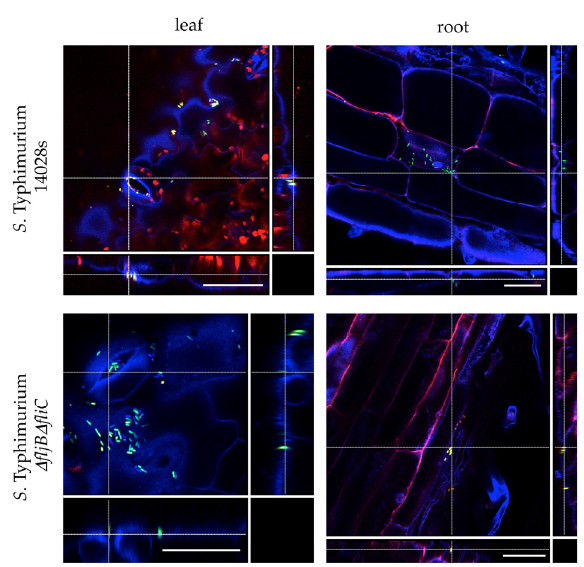
Figure 2. Attachment to plants does not require flagella. Salmonella enterica serovar Typhimurium strain 14028s ( S. Typhimurium 14028s) and the double mutant S . Typhimurium ∆ fljB ∆ fliC were labeled with the green fluorescent protein (GFP) using the pSM1890 GFP-plasmid. Plants were dip-inoculated with a 10 8 CFU / mL suspension of GFP-expressing Salmonella . Attachment of Salmonella to plant roots and leaves was assessed after 24 h, using the confocal laser scanning microscopy with the following set up: excitation 405 nm, emission 430–480 nm (blue); excitation 488 nm, emission 500–550 nm (green) and excitation 561nm, emission 600–680 nm (red). Auto-fluorescence of chloroplasts is indicated in red and GFP-labeled Salmonella cells are indicated in green. Scale bars indicate 20 µ m. The cross lines in orthogonal scaling are pointing the corresponding areas.